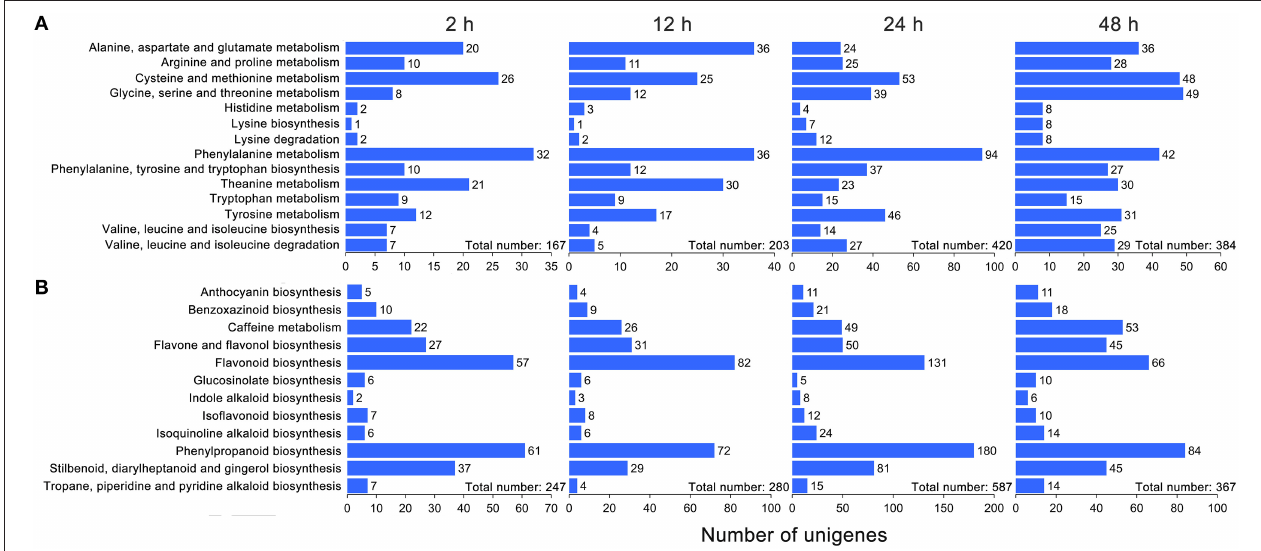
FIGURE 3 | KEGG ontology (KO) enrichment analysis of DEGs related to amino acid metabolism and secondary metabolism in C. sinensis leaves under drought stress. Five hundred and seventy-two and 661 DEGs were annotated and found to be associated with amino acid metabolism (A) and secondary metabolism (B) , respectively, based on the KEGG database.